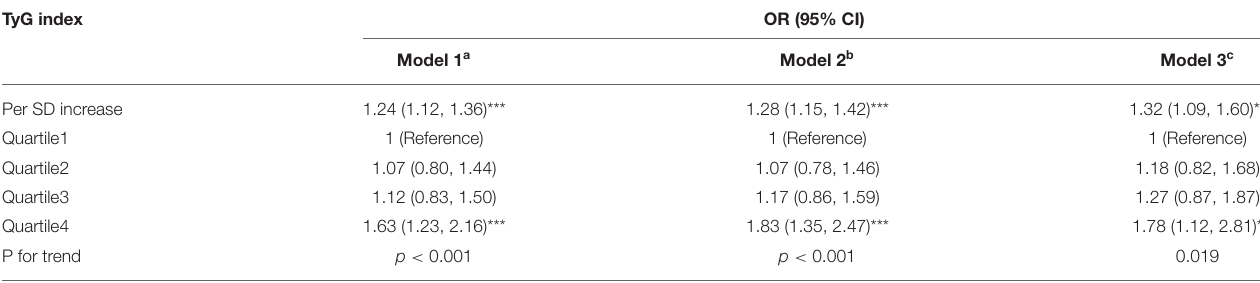
TABLE 4 | Logistic regression analyses for the association between TyG index and high baPWV.